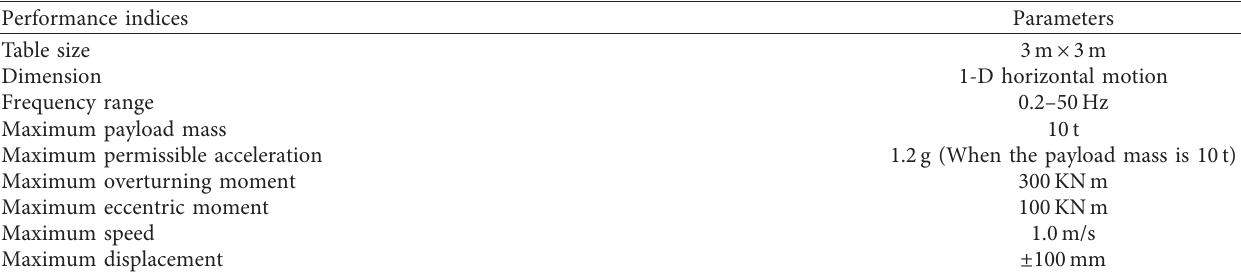
Table 1: Performance parameters of the shaking table.